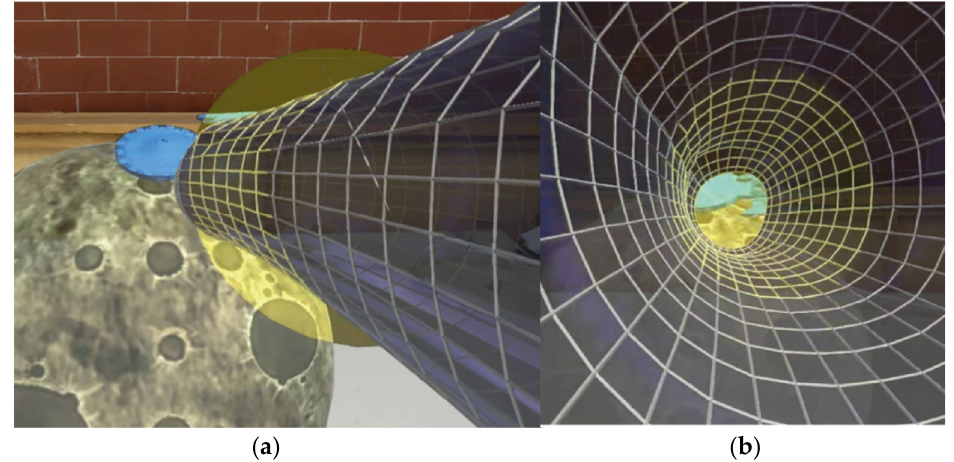
Figure 1. Frames of the HL2 view during the exergaming: ( a ) space environment considered for the exergaming from a lateral vision, in blue the spaceship the patient has to reach; ( b ) space environment from a frontal vision, inside the wormhole-like object that limits the volume of work.